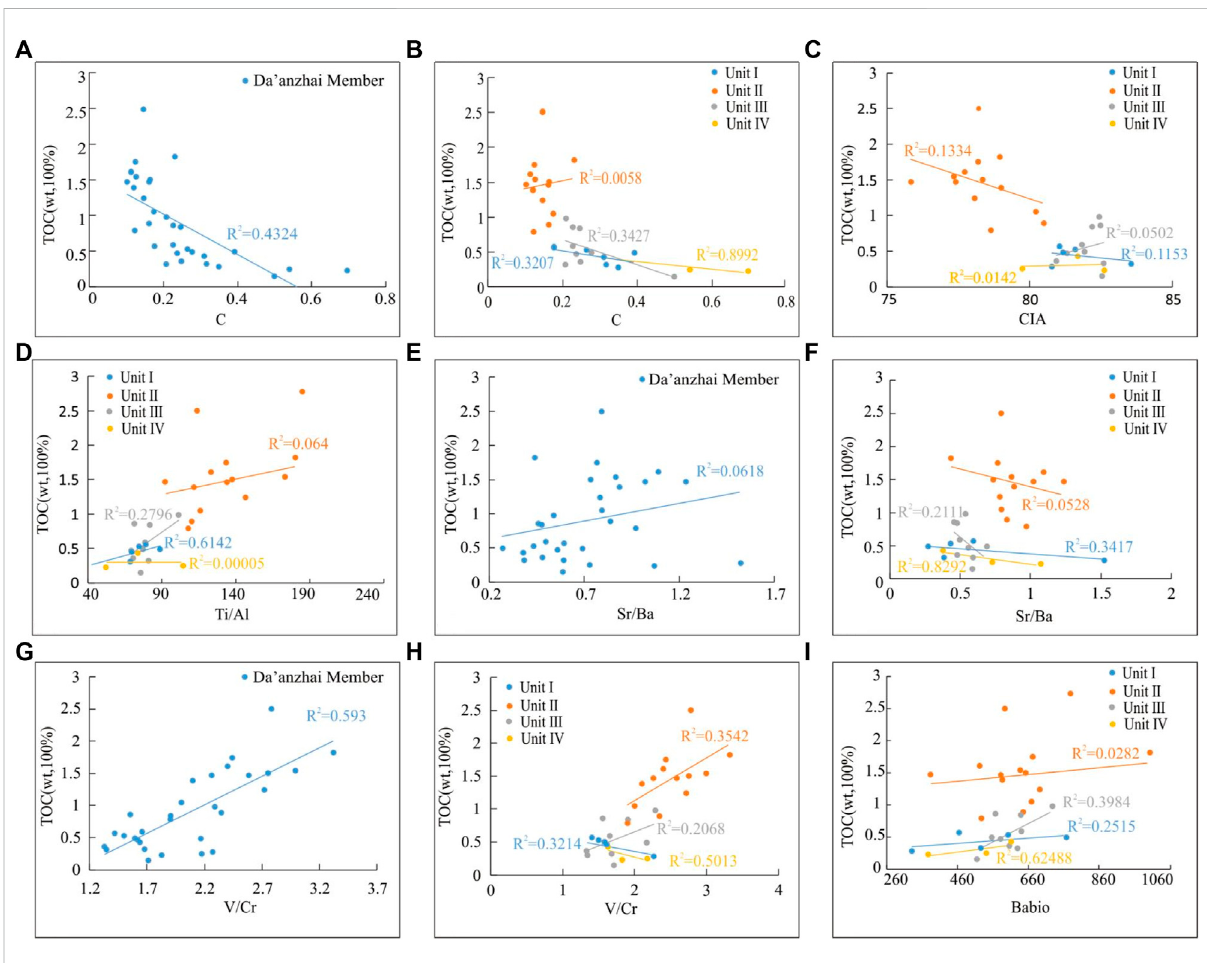
FIGURE 8 Cross-plot of environment parameter and TOC in the Da ’ anzhai member of well C. (A) Correlation between TOC and C in Da ’ anzhai Member; (B) Correlation between TOCand C infour small layers; (C) Correlation betweenTOC andCIA in four smalllayers; (D) Correlation betweenTi/Al and C in four small layers; (E) Correlation between TOC and Sr/Ba in Da ’ anzhai Member; (F) Correlation between TOC and Sr/Ba in four small layers; (G) Correlation between TOC and V/Cr in Da ’ anzhai Member; (H) Correlation between TOC and Cr in four small layers; (I) Correlation between TOC and Babio in four small